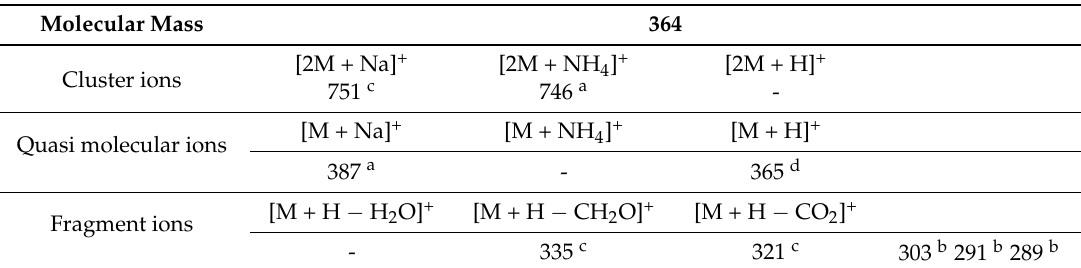
Table 2. ESI/MS fragmentation of justicidin B